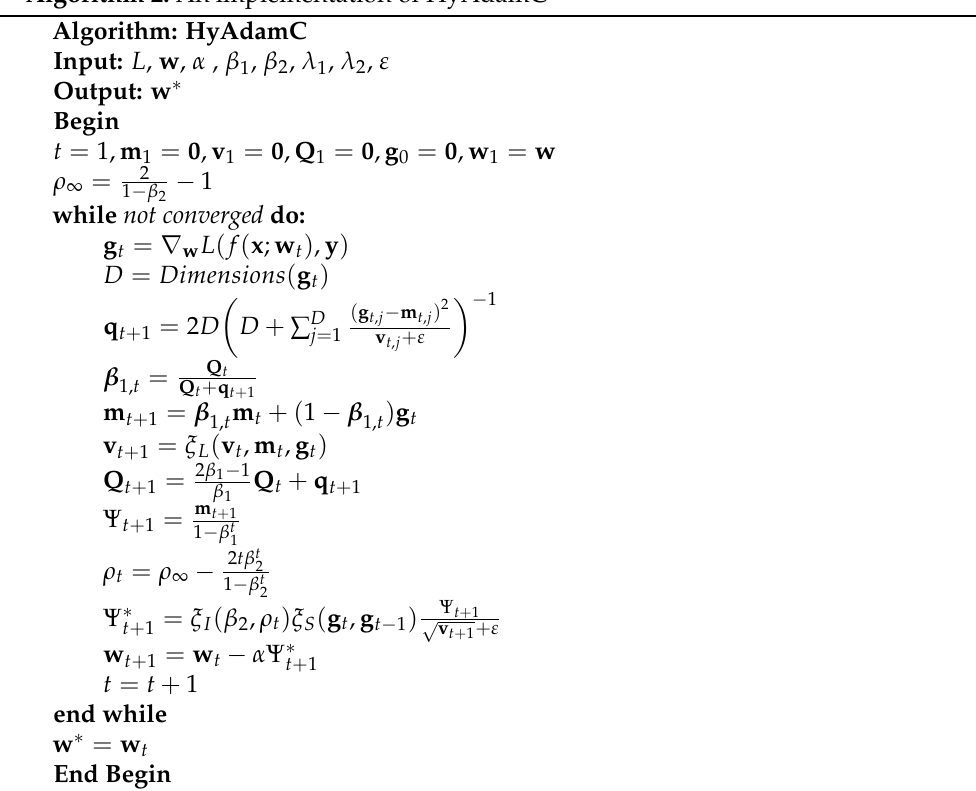
Algorithm 2: An implementation of